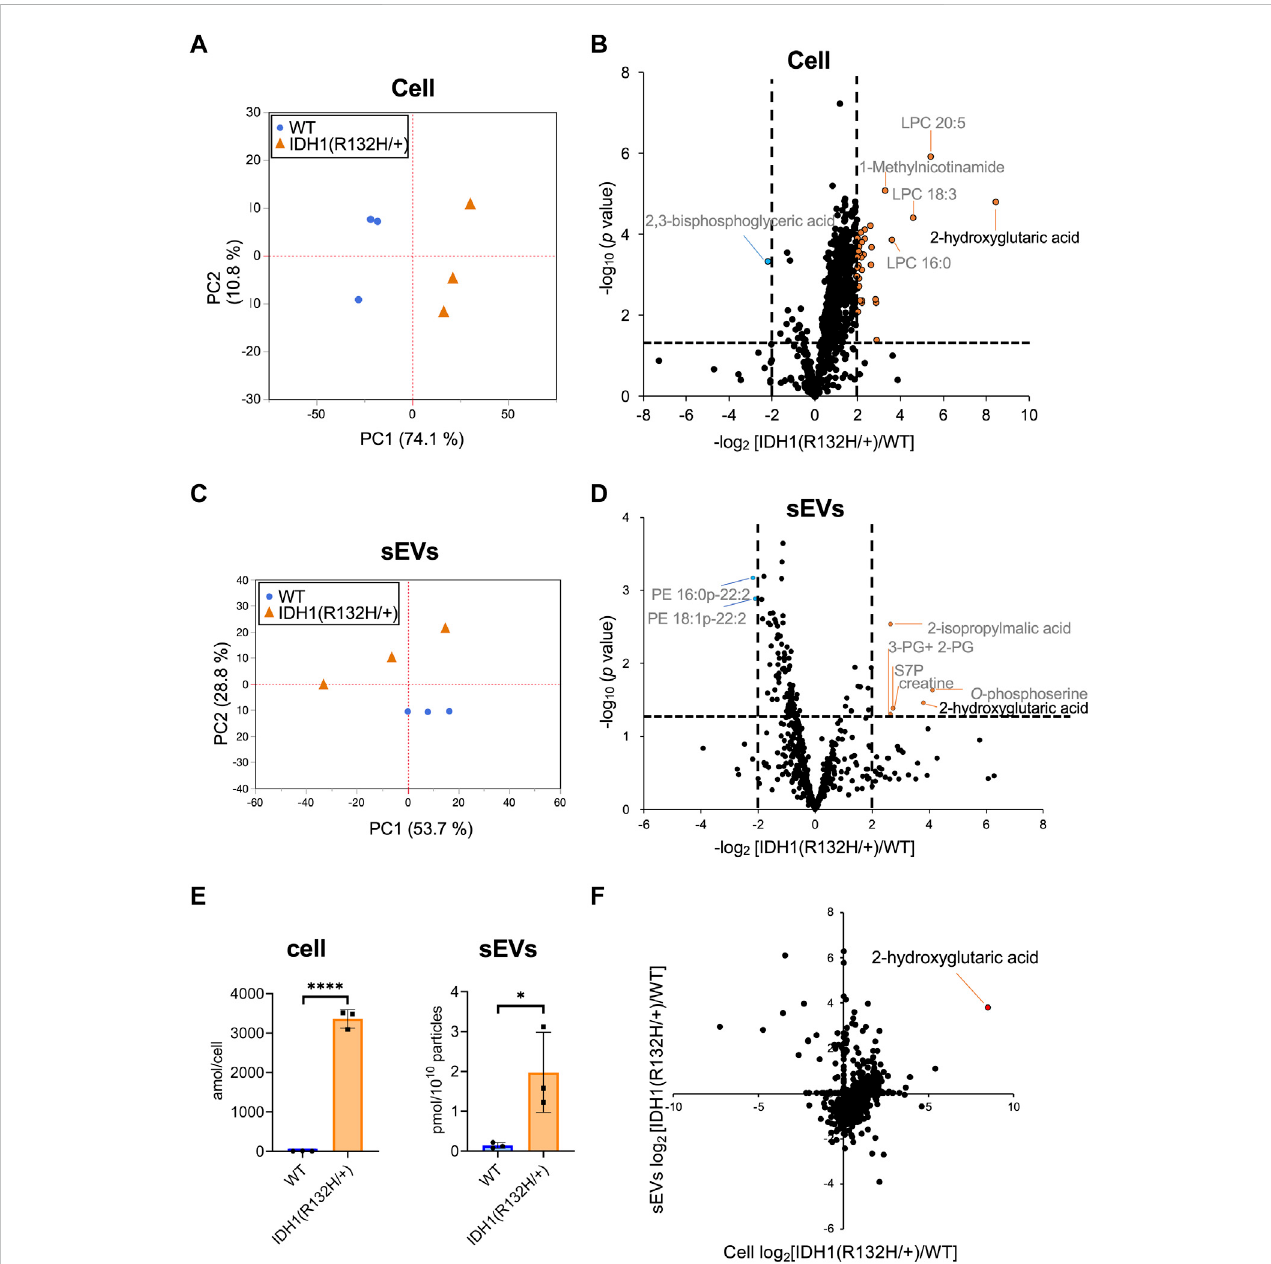
FIGURE 5 Effects of IDH1(R132H/+) mutations on metabolites in cells and extracellular vesicles (A) Principal component analysis (PCA) score plots between wild- type (WT, blue circles) and IDH1(R132H/+) (orange triangles) cells. (B) The result of a Student ’ s t-test for WT EVs vs IDH1(R132H/+) is displayed as a volcano plot. The orange and blue plots are for the metabolites that increased and decreased between WT and IDH1(R132H/+), respectively. p -value < .05, fold- change > 4. (C) PCA score plots between WT (blue circles) and IDH1(R132H/+) (orange triangles) in sEVs. (D) The volcano plots illustrate the quantitative differences in metabolites in the sEV fraction. The plots marked orange and blue are same as (B) . (E) Levels of 2-hydroxyglutarate in cells and EVs. Data are represented as mean ± SD. * p -value < .05, ** p -value < .001. (F) The relationship between cellular and sEVs variability. The x- and y -axes indicate the variation in cell and sEVs, respectively. Variation was calculated as the ratio of IDH1 (R132H/+) to